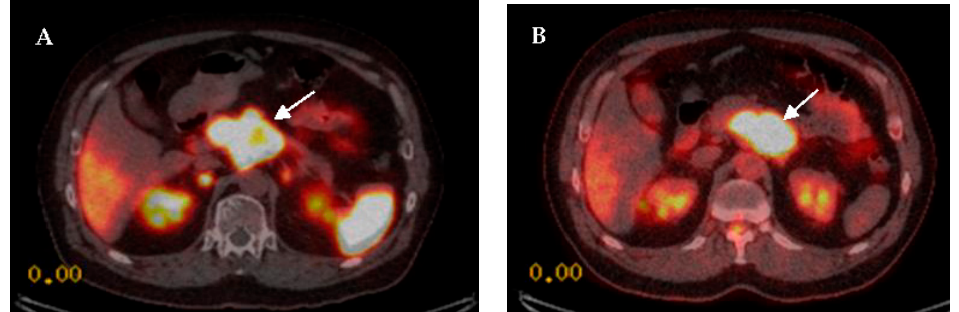
Figure 3. A patient with pathological proven pancreatic NENs (G3, Ki ‐ 67 of 30%). Axial 68 Ga ‐ DOTA ‐ NOC PET/CT image (( A ), arrow) reveals intense radiotracer uptake at the body of the pancreas and is also seen in axial 18 F ‐ FDG PET/CT image (( B ), arrow). The value of combined PET studies is to demonstrate the heterogeneity of GEP ‐ NENs, especially in high ‐ grade NENs, and could determine the appropriate therapy.